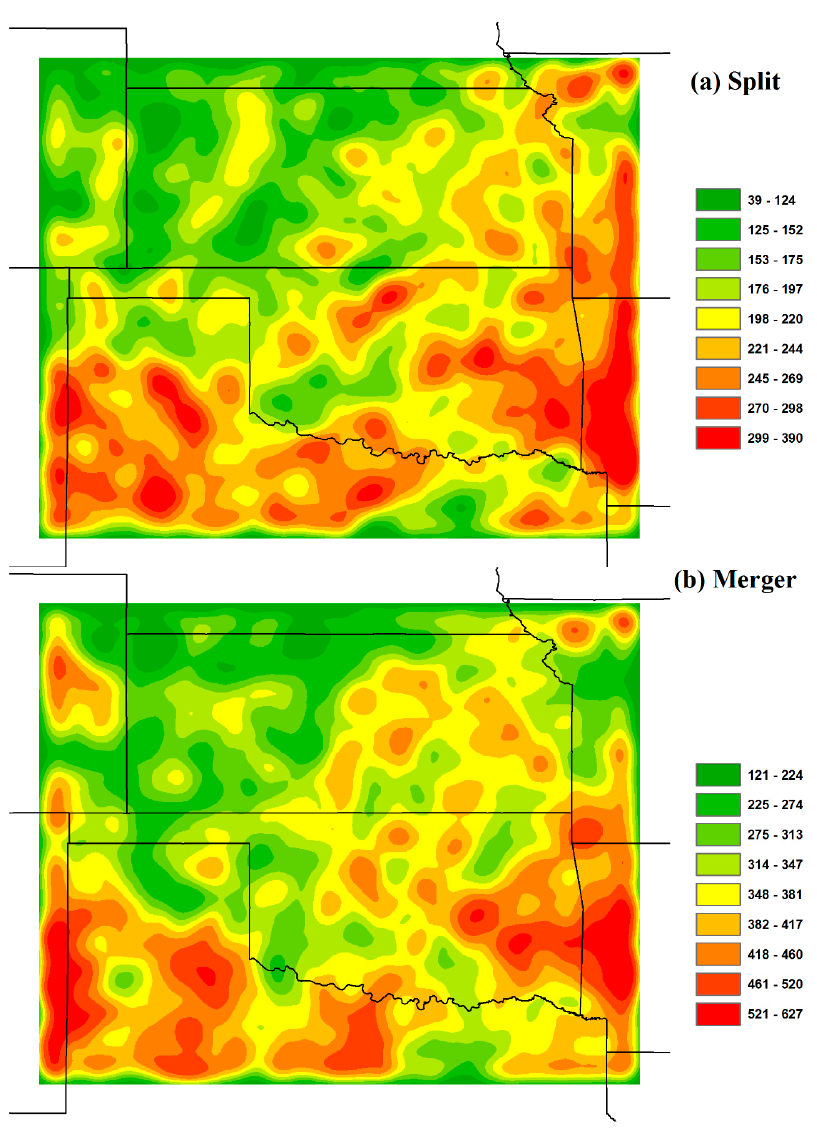
Figure 11. Thunderstorm cell split ( a ) and merger ( b ) density (count/km 2 ) maps.